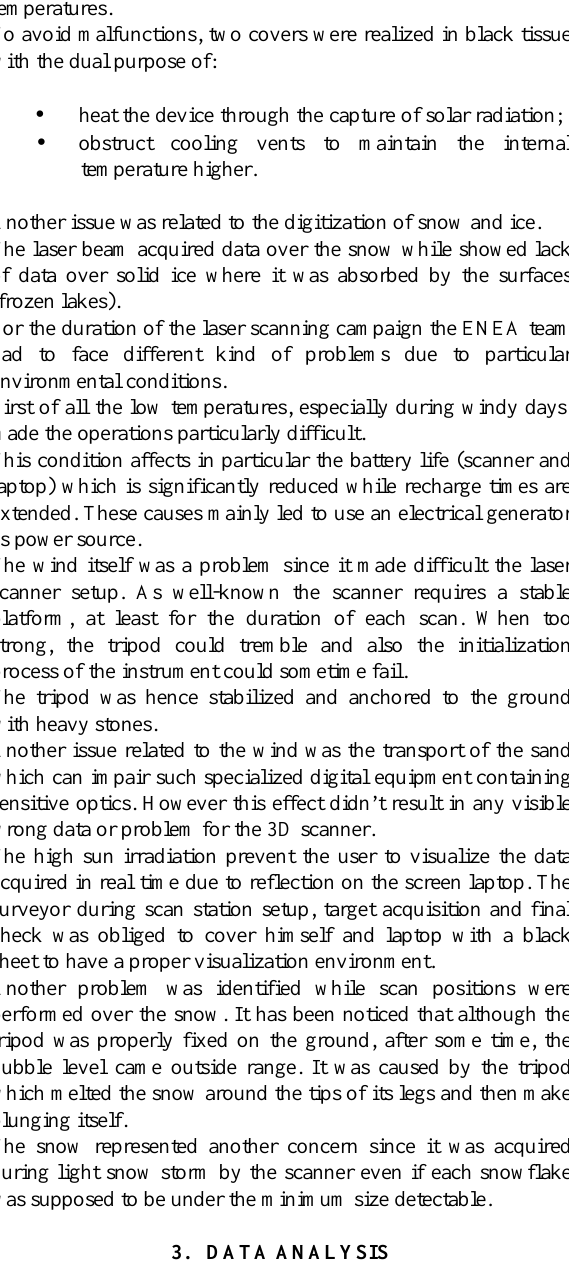
Table 4. DGPS UTM-WGS84 GPS